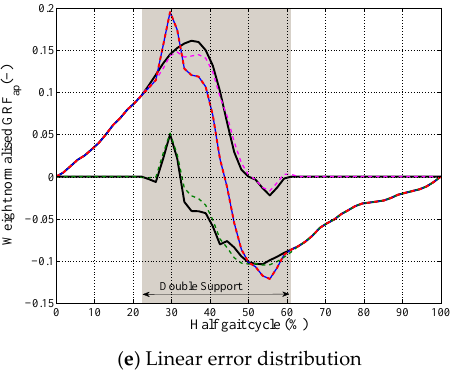
Figure 6. TPM procedure for estimation of hGRF ap ( t )